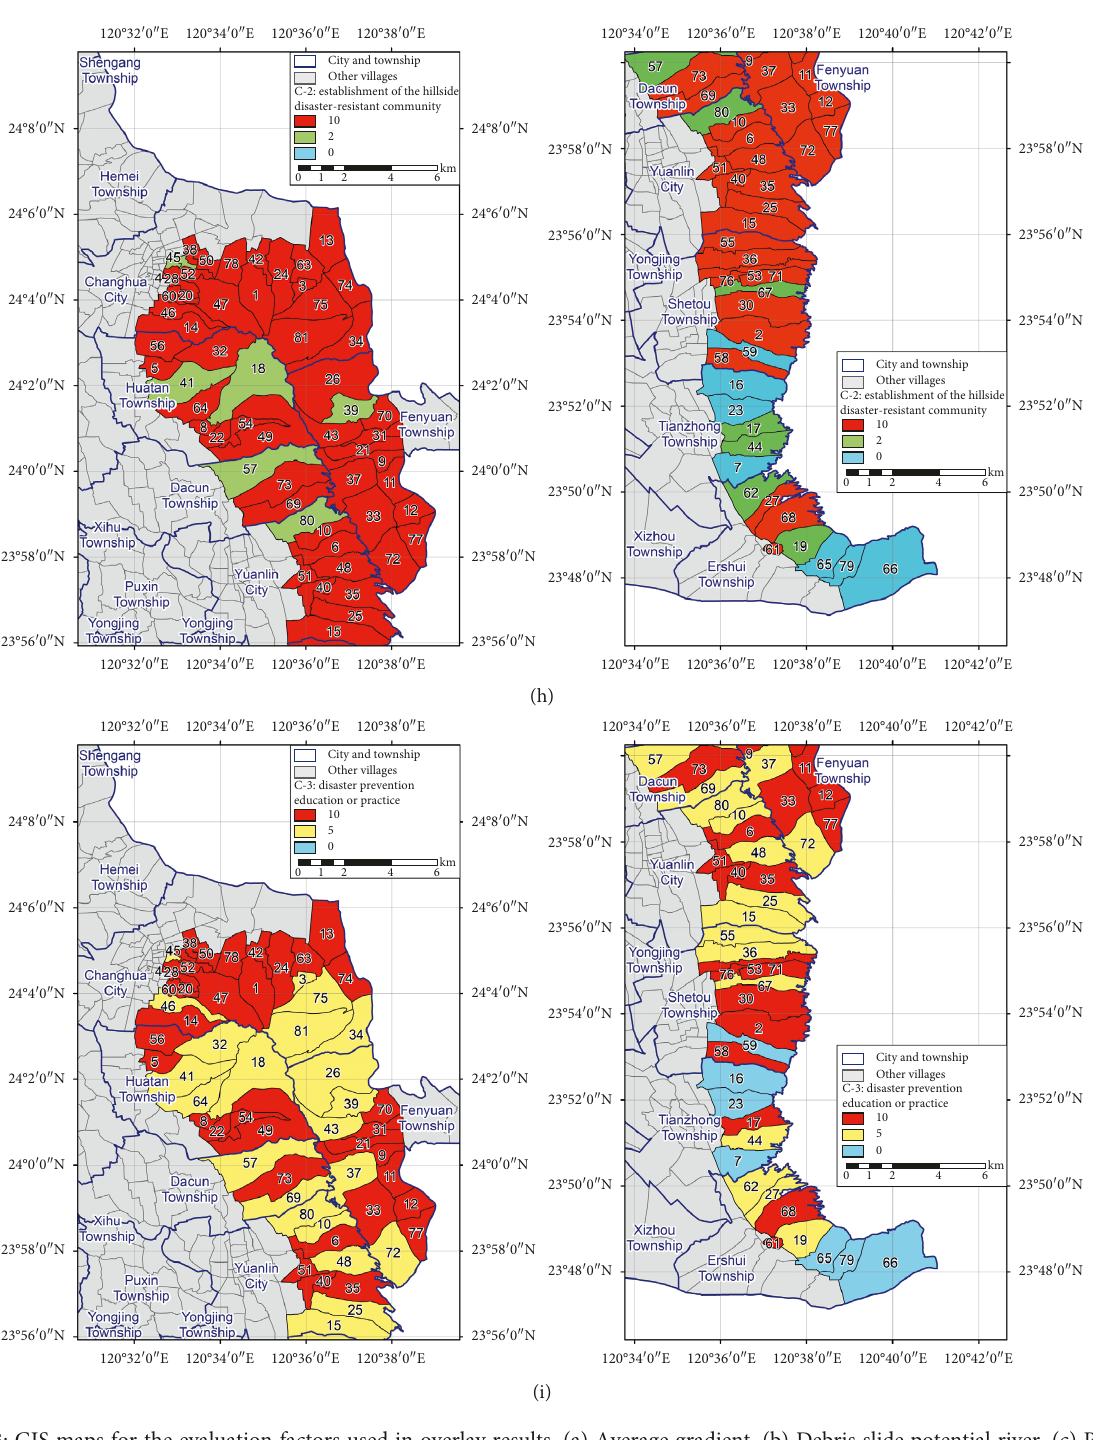
Figure 3: GIS maps for the evaluation factors used in overlay results. (a) Average gradient. (b) Debris slide potential river. (c) Potential debris flow torrent. (d) Major historical disaster. (e) Total debris slide area. (f) Potential debris flow torrent area. (g) Effect on secured objects. (h) Establishment of the hillside disaster-resistant community. (i) Disaster prevention education or